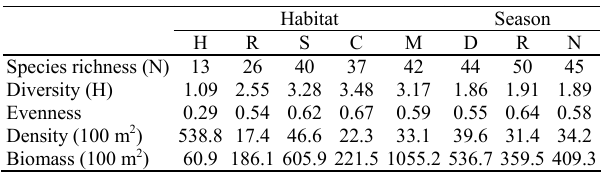
Table 4. Ecological parameters considering each type of habitat in the Ría Lagartos Lagoon, Mexico (hyperhaline: H, rocky: R, seagrass: S, channel: C, marine: M) and season (dry: D, rainy: R, northerlies: